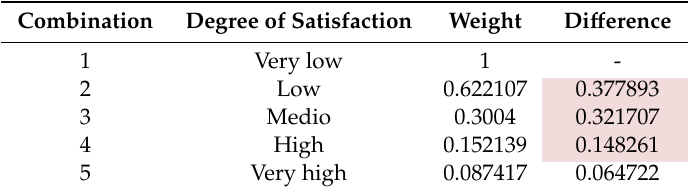
Table 21. Top–down technique for the criterion Sta ff